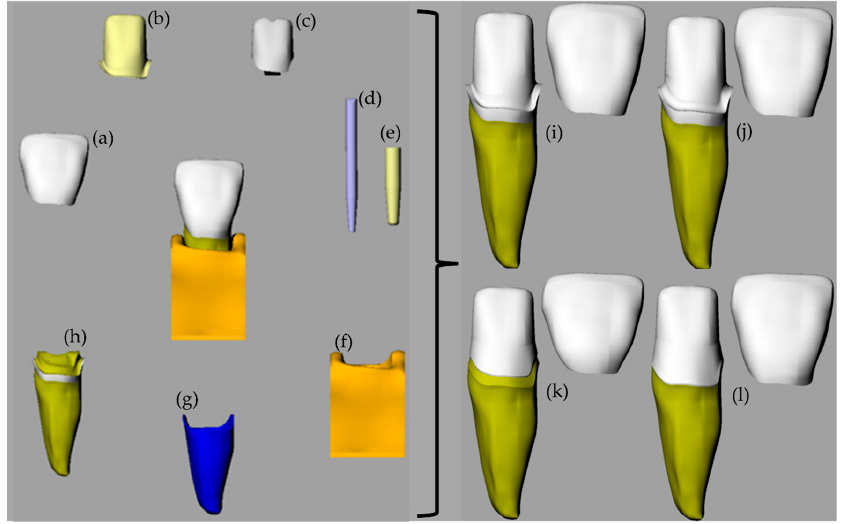
Figure 1. The geometric features of the analyzed model according to the preparation type. ( a ) Ceramic crown, ( b ) resin cement, ( c ) core build-up, ( d ) fiberglass post, ( e ) post cement, ( f ) bone tissue, ( g ) periodontal ligament, ( h ) root dentin and enamel, ( i ) SM model, ( j ) CM model, ( k ) BOPT model and ( l ) BOPTB model.